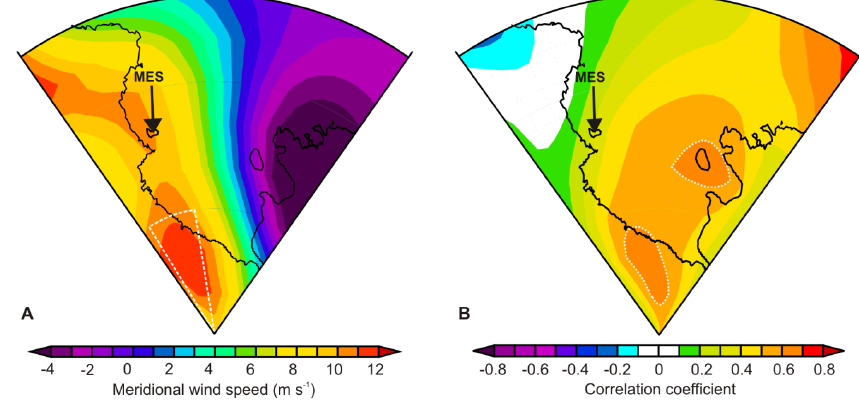
Fig. 10. (A) NCEP/NCAR reanalysis 850mb meridional wind composite mean for the winter months (JJA) of 1979–2006AD across the Ross Sea region (90–70 ◦ S, 150–220 ◦ E). White dashed line defines the source region of meridional winds arriving at MES. (B) Spatial correlation pattern between meridional wind (850mb) and MES Al concentration record for the winter months (JJA) of 1990–2000AD across the Ross Sea region. White dashes outline region of significant correlation ( p < 0.025, n = 10).